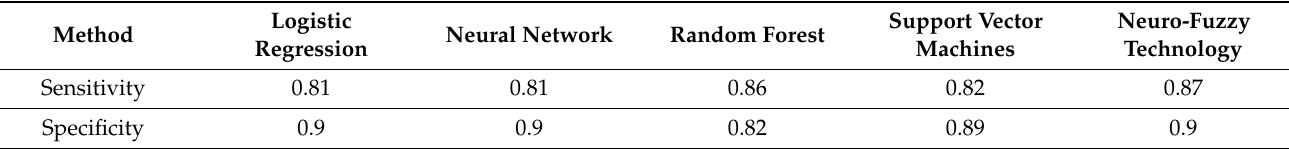
Table 3. PDAC detection performance of five machine learning algorithms in PancRisk